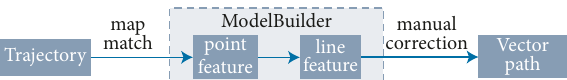
Figure 4: The technical flow of path generation from locus points.